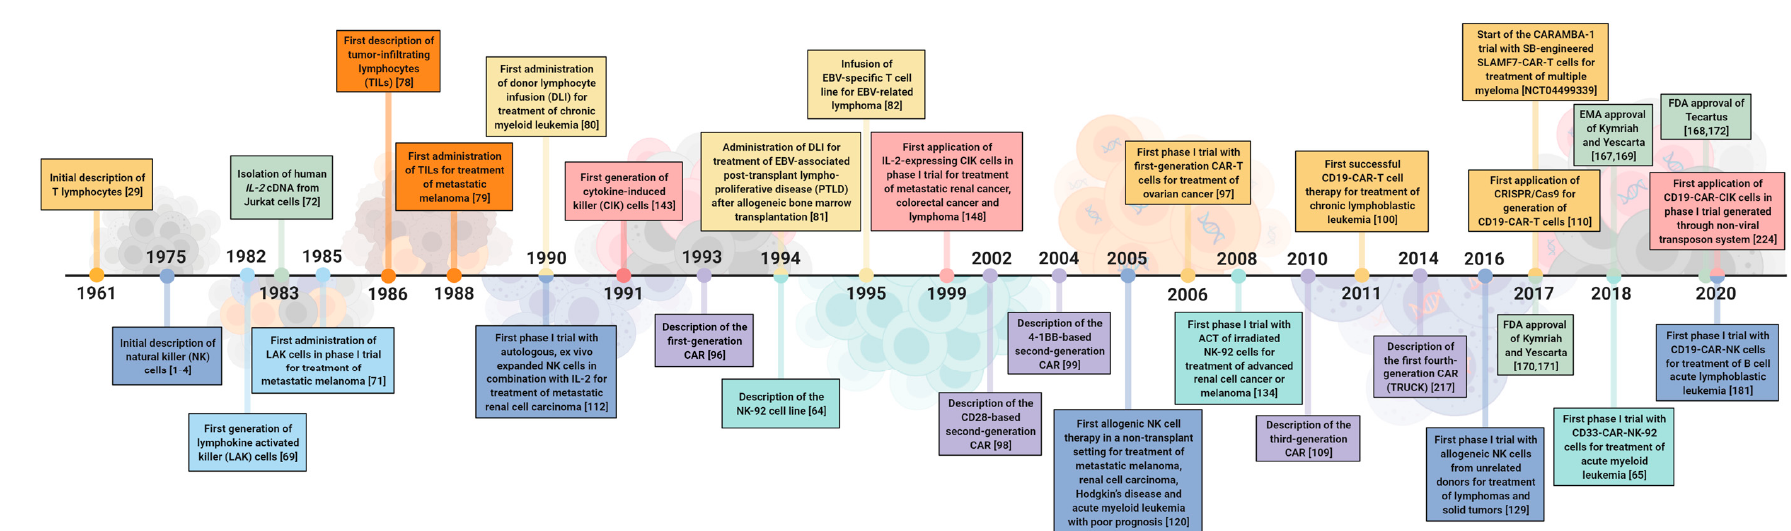
Figure 1. The history of cell-based immunotherapies. Important discoveries, key clinical trials and highlights which were prominent in the last decades of cell-based immunotherapies are illustrated. ACT = adoptive cell therapy; CAR = chimeric antigen receptor; CD = cluster of differentiation; CRISPR = clustered regularly interspaced short palindromic repeats; Cas9 = CRISPR-associated endonuclease 9; EBV = Epstein–Barr virus; EMA = European Medicines Agency; FDA = U.S. Food and Drug Administration; IL-2= interleukin 2; SB = Sleeping Beauty transposon/transposase system; TRUCK = T cells redirected for universal cytokine killing.